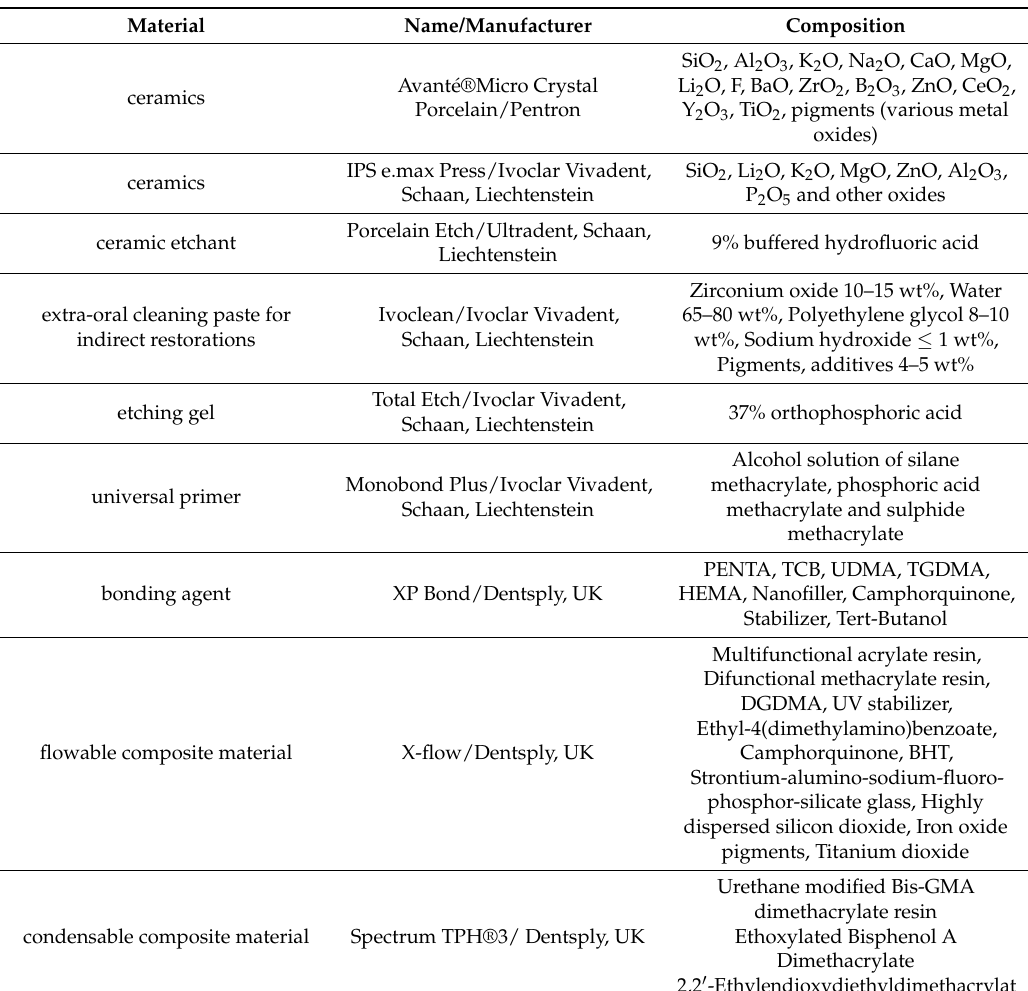
Table 3. Materials used in the